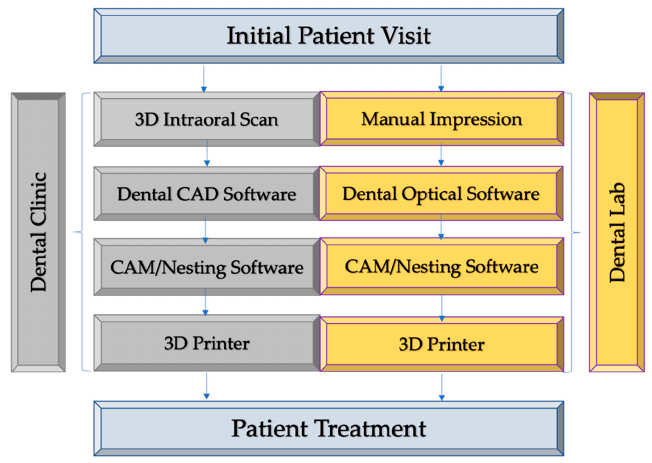
Figure 1. Digital workflow of dental diagnosis and treatment using CAD/CAM and 3D printing technology.